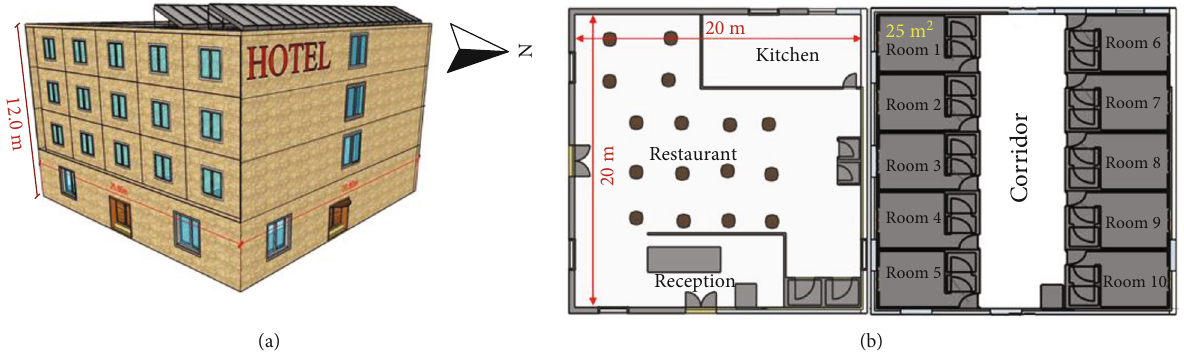
Figure 3: (a) 3D sketch of the hotel and (b) 2D cross-section for ground and fi rst fl oor Table 2: Building envelope ’ s construction speci fi cations [23, 24].